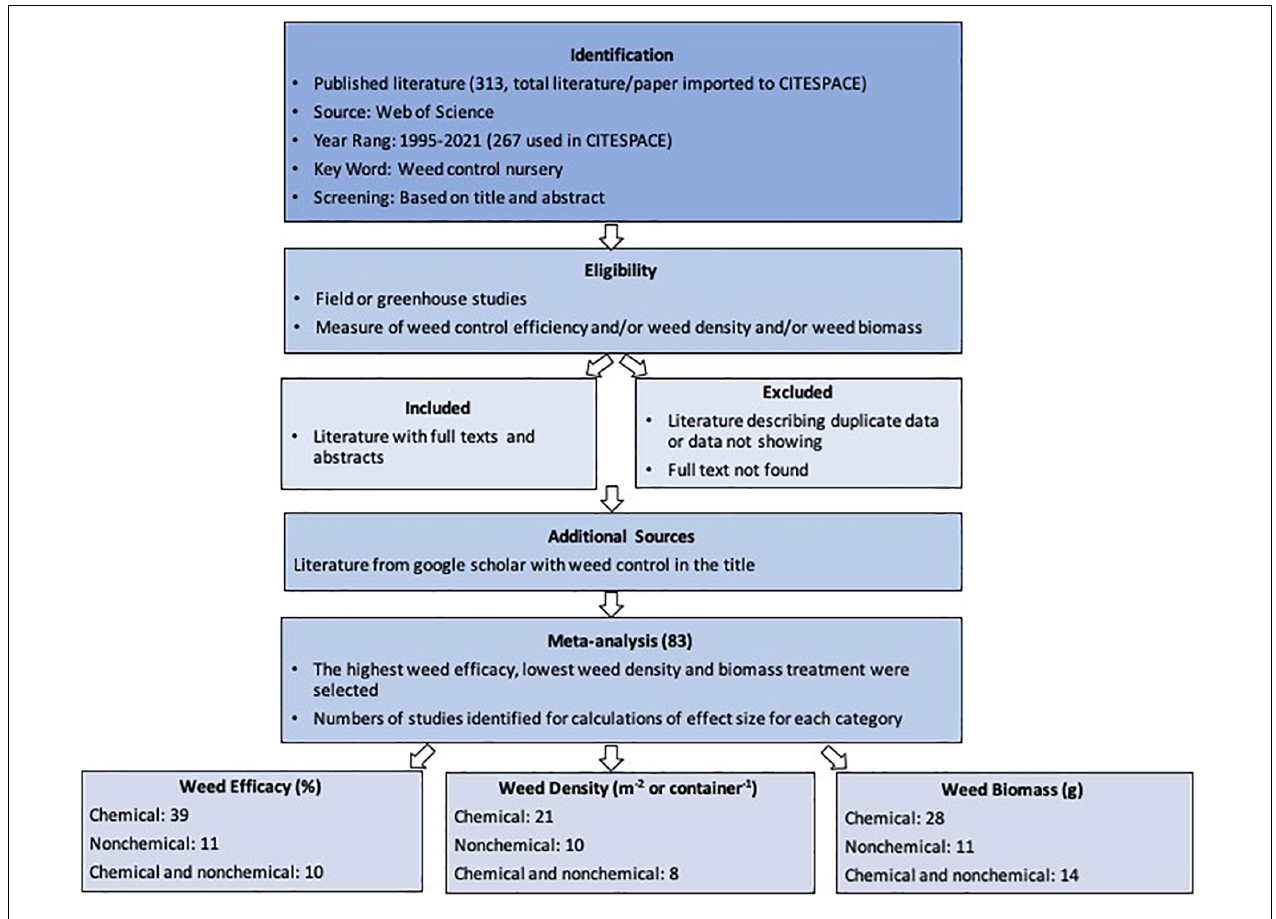
FIGURE 1 | Flow diagram showing the study selection procedure.